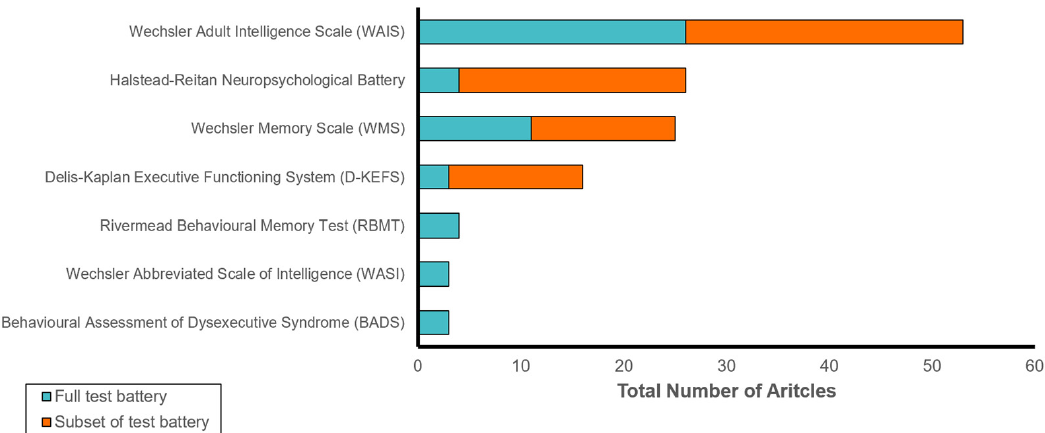
Figure 3. Cognitive instruments using test batteries or battery subsets appearing in three or more articles included in this review. Articles are arranged by frequency of appearance.